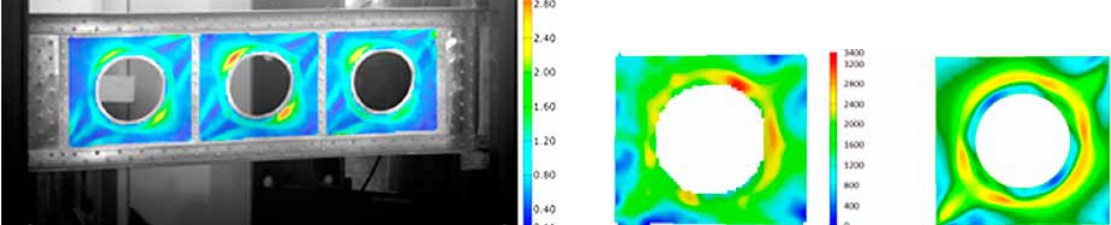
Fig. 10. Deflections of specimens: test vs FEA